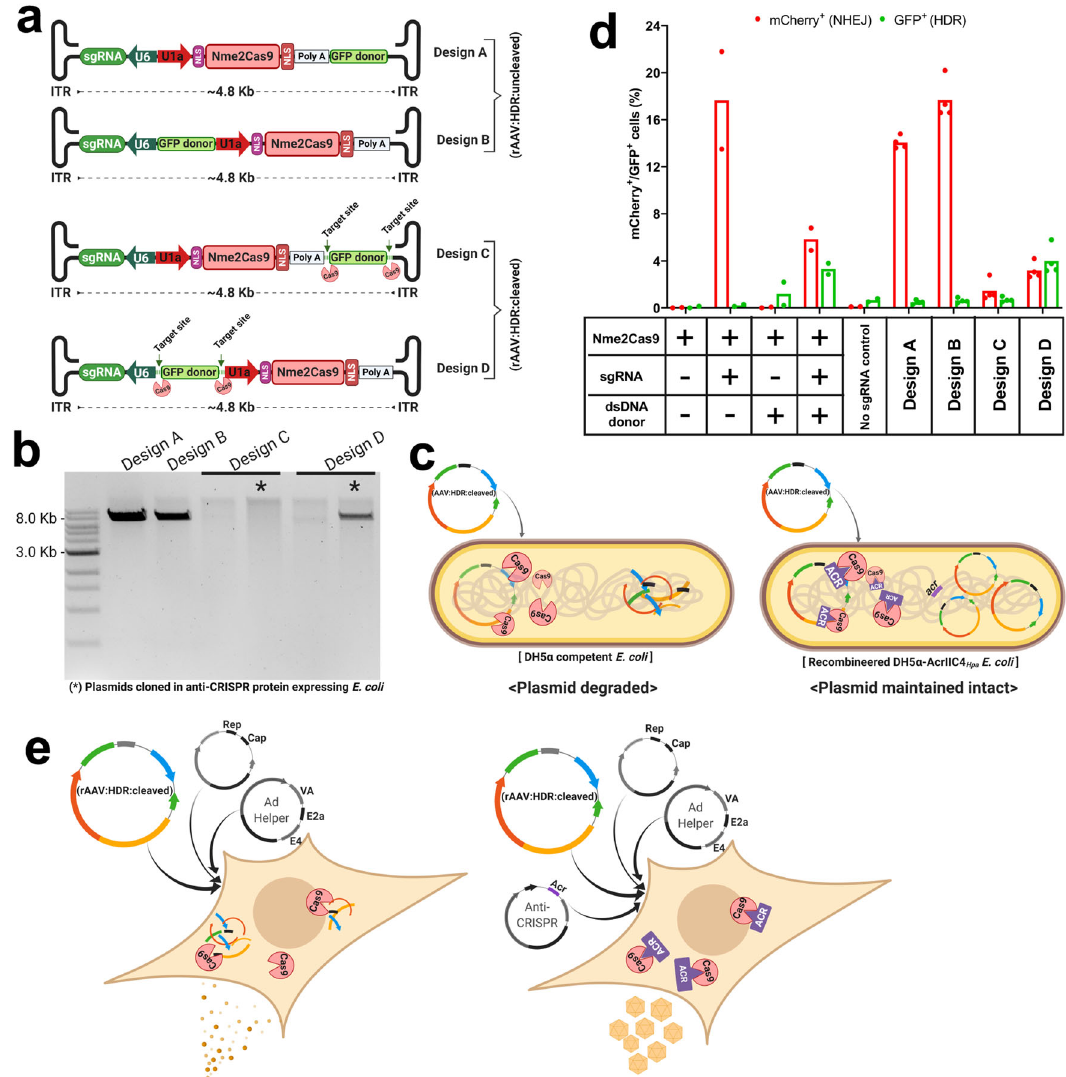
Fig. 3 In vitro design and validation of all-in-one, self-inactivating rAAV:HDR vectors. a Schematic of four different vector designs of rAAV:HDR constructs containing an sgRNA expression cassette, Nme2Cas9, and a donor DNA (<500 bp) with and without fl anking sgRNA target sites. b Agarose gel electrophoresis (1% agarose) of linearized AAV:HDR plasmids. Asterisks indicate self-inactivated AAV:HDR plasmids that were cloned using anti-CRISPR- protein-expressing E. coli DH5 α . DNA size marker size is 1 kb. Multiple plasmids were analyzed in this fashion three separate times, with consistent results. c Schematic of conventional E. coli DH5 α and the recombined, anti-CRISPR-protein-expressing derivative used to successfully clone the self-targeting rAAV:HDR:cleaved plasmids. d Ef fi ciencies of NHEJ and HDR events depicted as percentages of mCherry- and GFP-positive cells, respectively, obtained after transfection of AAV:Nme2Cas9:sgRNA and dsDNA GFP donor in trans ), or of rAAV:HDR constructs in TLR-MCV1 HEK293T cells. The sample size represents independent transfection experiments ( n = 2 of Nme2Cas9, sgRNA, and dsDNA donor in trans delivery; while n = 4 biological replicates of in cis delivery of AAV:HDR plasmids Designs A, B, C, and D). e Schematic of modi fi ed rAAV packaging transfection system using anti-CRISPR protein plasmid to block self-targeting by Nme2Cas9 expression in packaging cells during